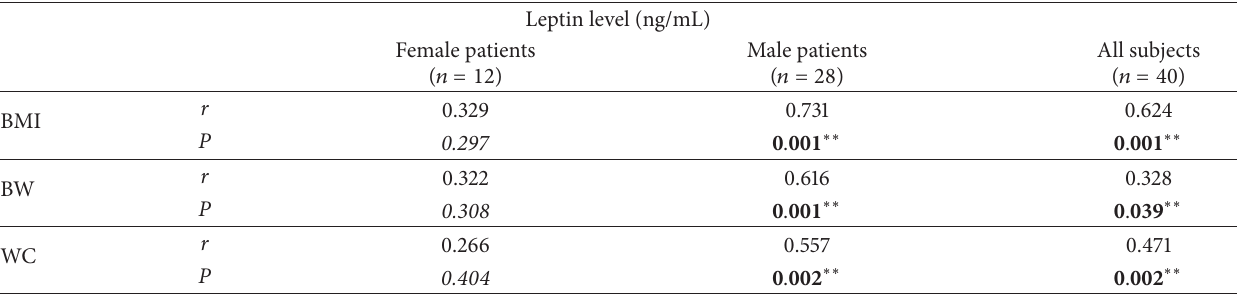
Spearman correlation analysis. ∗∗ 𝑃 < 0.01 . Table 3: Correlation of leptin levels, BMI, and WC with age, gender, and use of dopamine agonist treatment. BMI (kg/m 2 ): body mass index; WC (cm): waist circumference.